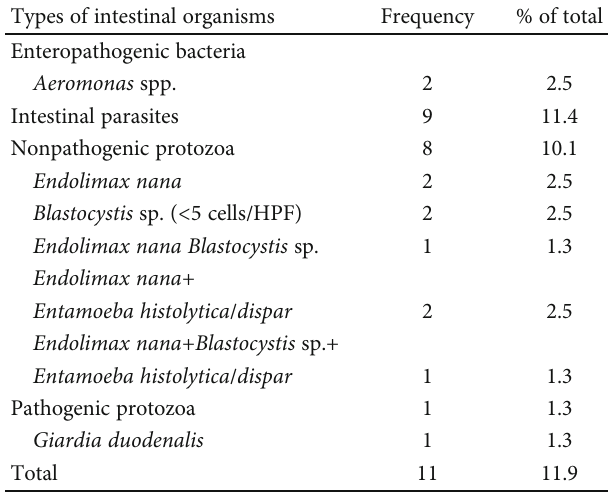
Table 2: Incidence of enteropathogenic bacterial and intestinal parasitic infections from the stools of beverage and food handlers at RSU canteens ( n = 79